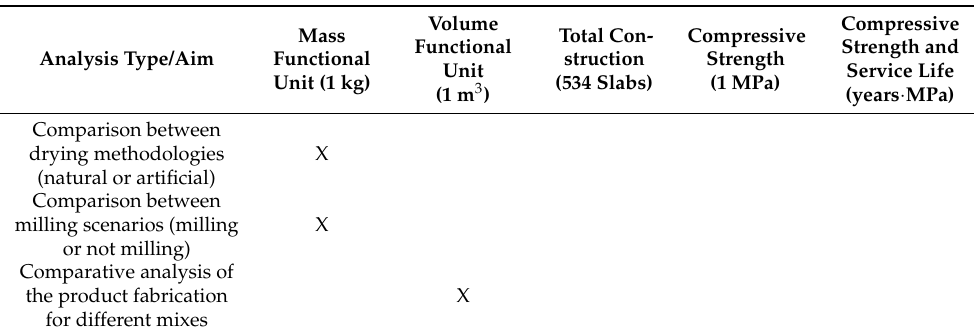
Table 4. Functional units used in the current study to evaluate each different aspect of the environ- mental impact categories